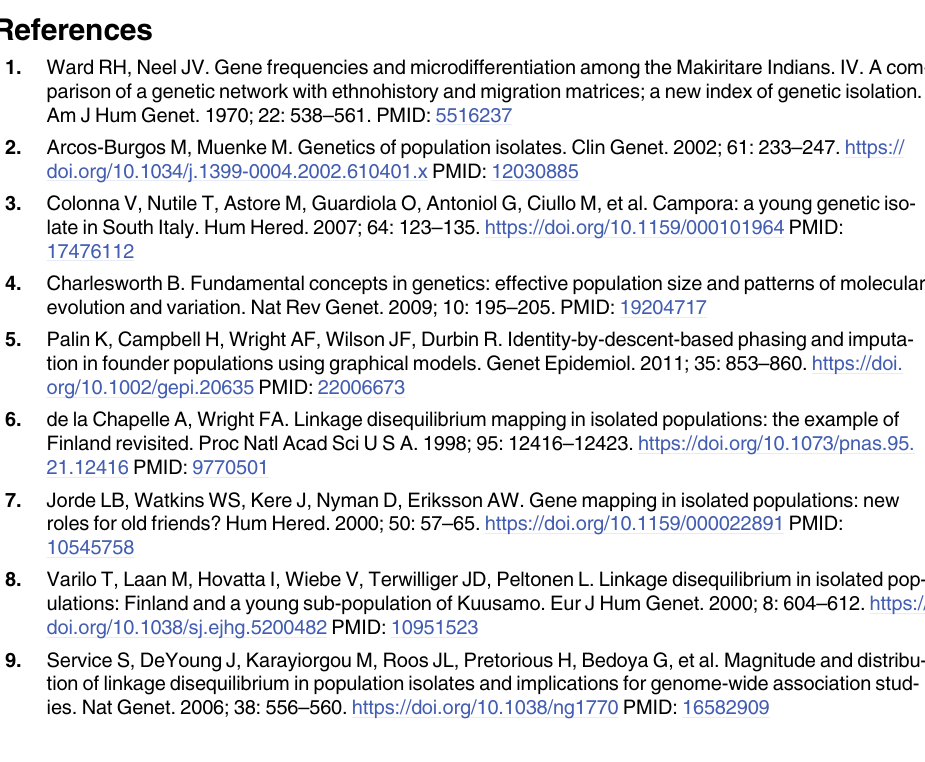
S7 Table. Inbreeding coefficient values. Calculated as the proportion of the autosomal genome in runs of homozygosity, excluding the